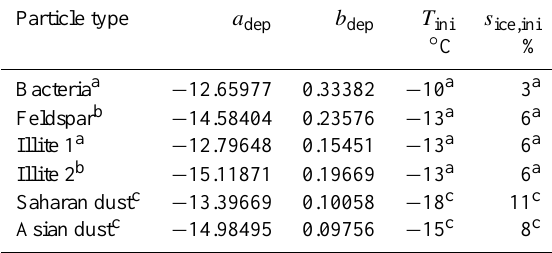
Table 4. Values of deposition freezing constants a dep and b dep in Eq. (15) and values of lower limits of temperature T ini and ice su- persaturation s ice,ini . Based on data from a A. Danielczok and H. Bingemer (personal communication, 2014), b Yakobi-Hancock et al. (2013), and c K. Ardon-Dryer and Z. Levin (personal communi- cation,